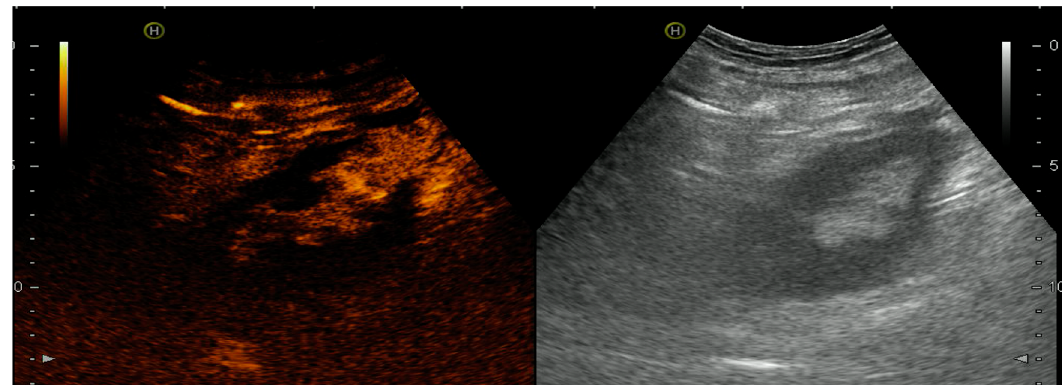
Figure 3. The slope in grafts with acute complication is flattened identifying a worse washout of contrast.